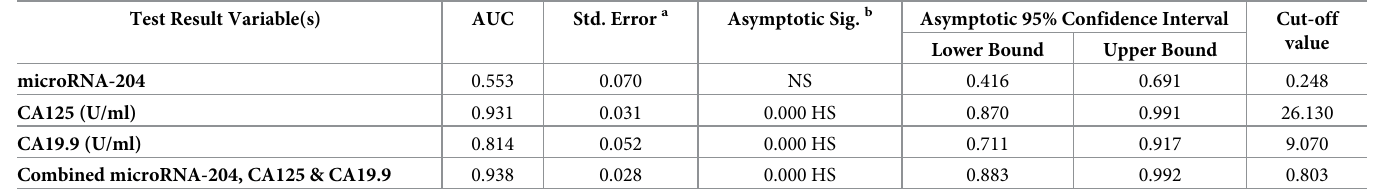
Table 3. Area under the curve (AUC) and a cut-off value of microRNA-204, CA125, CA19.9, and combined microRNA-204, CA125, and CA19.9 in benign ovarian